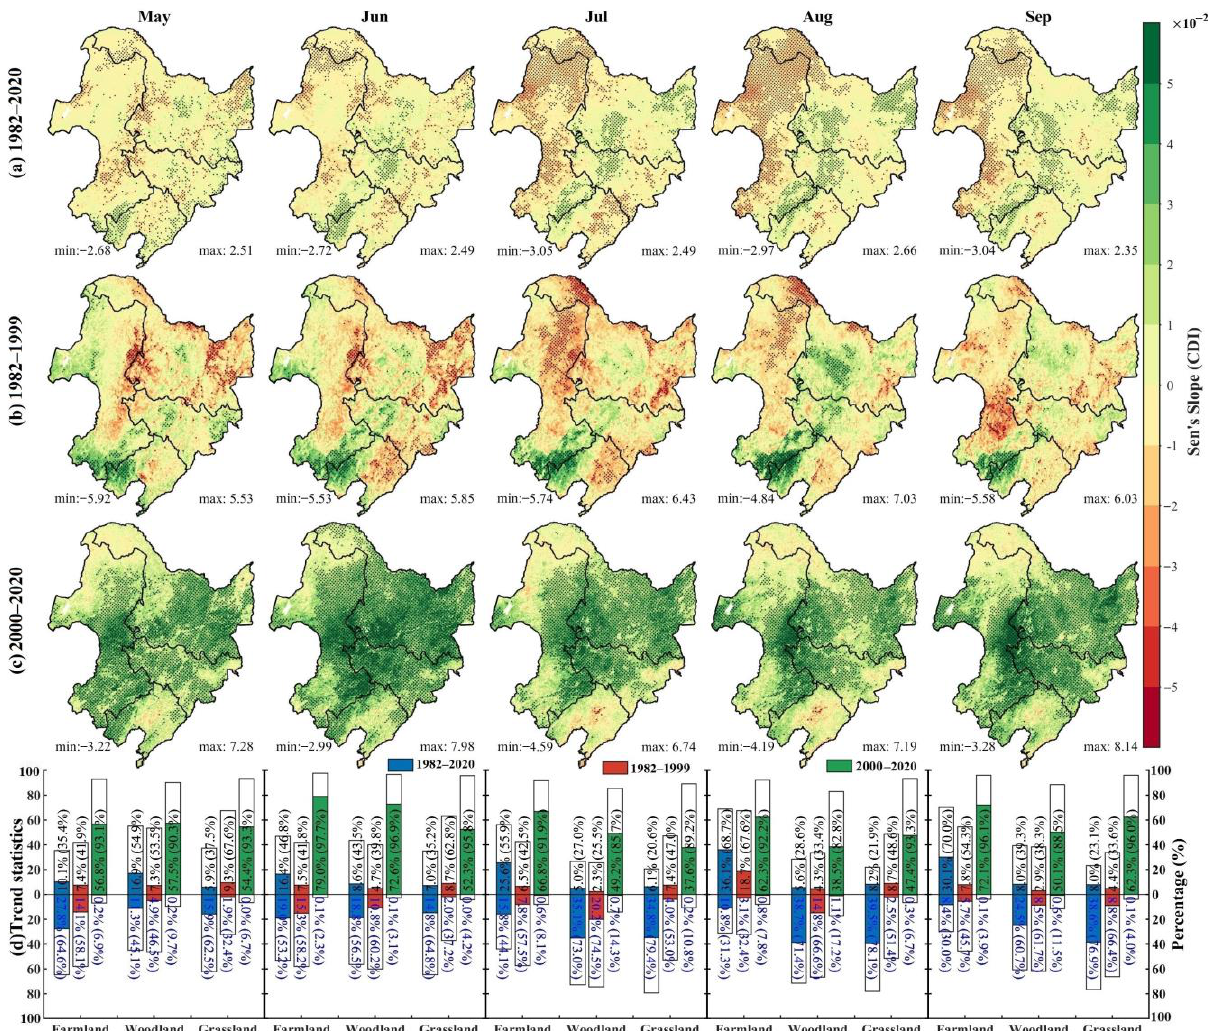
Figure 7. Spatial pattern ( a – c ) and statistics ( d ) of CDI trends during the growing season in NEC at different periods. (Dotted area indicates an MK significance test of |Z| > 1.96; the upper part of the bar graph indicates the proportion of the grid with an increasing trend, and the colored part indicates the proportion of the grid with significant change.)